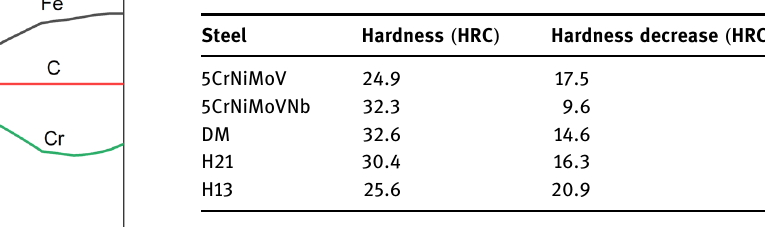
Table 3: The heat treatment process